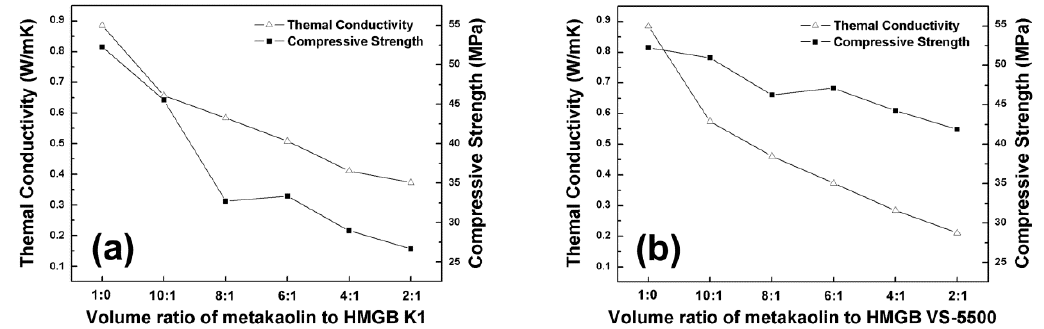
Figure 5. Thermal conductivity and compressive strength of alkali activated metakaolin-based geopolymers with different ratios of HMGB: ( a ) HMGB K1 and ( b ) HMGB VS-5500.